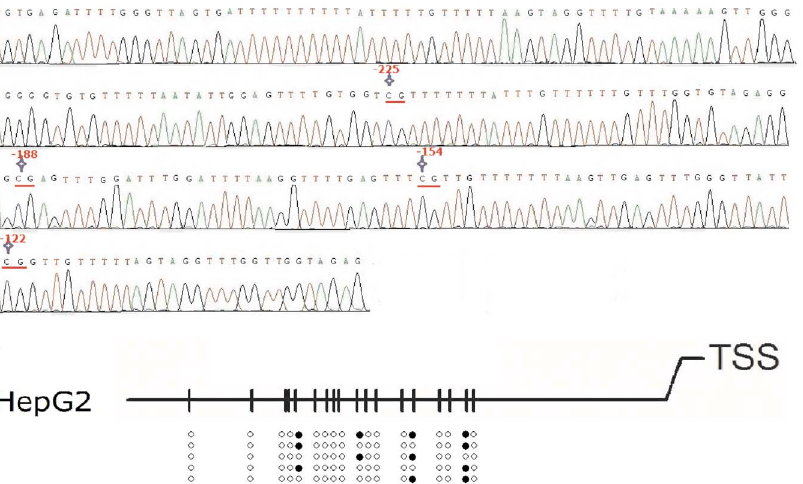
Figure 6. Methylation profiles of OCTN2 in DCA-treated HepG2 cells. (A), bisulfite genomic sequencing analysis of DCA-treated HepG2 cells. After the treatment of DCA, DNA was extracted and subjected to bisulfite modification. Bisulfite modified DNA was amplified by BSP as described under Materials and methods and then sequenced. Pointed star represents methylated CpG sites. (B), DNA methylation profiles of individual methylated CpG dinucleotides in DCA-treated HepG2 cells. After BSP, five clones were randomly selected and sequenced. The methylated sequences were checked for alignment using MethBLAST. The open and closed circles represent unmethylated or methylated cytosines, respectively.